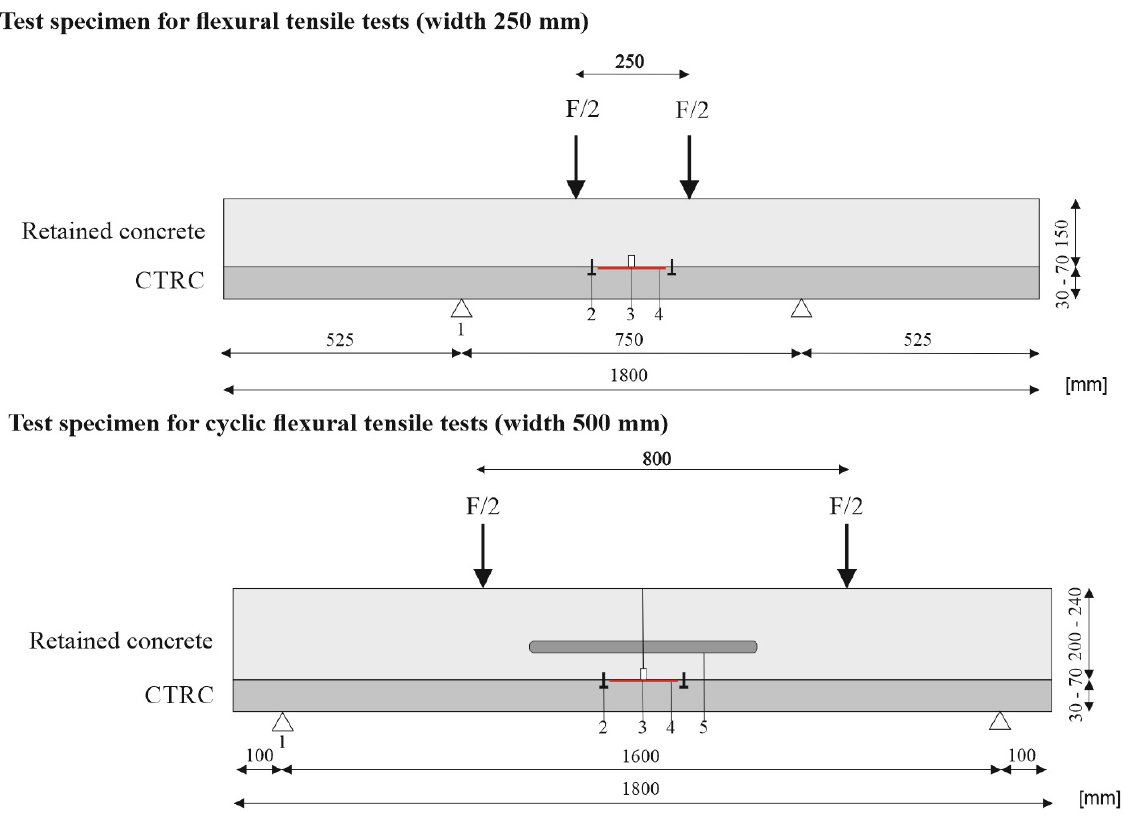
Figure 3. Specimens for flexural tensile tests. 1: bearing, 2: dowel, 3: simulated contraction joint, 4: bond breaker, 5: dowel bar.